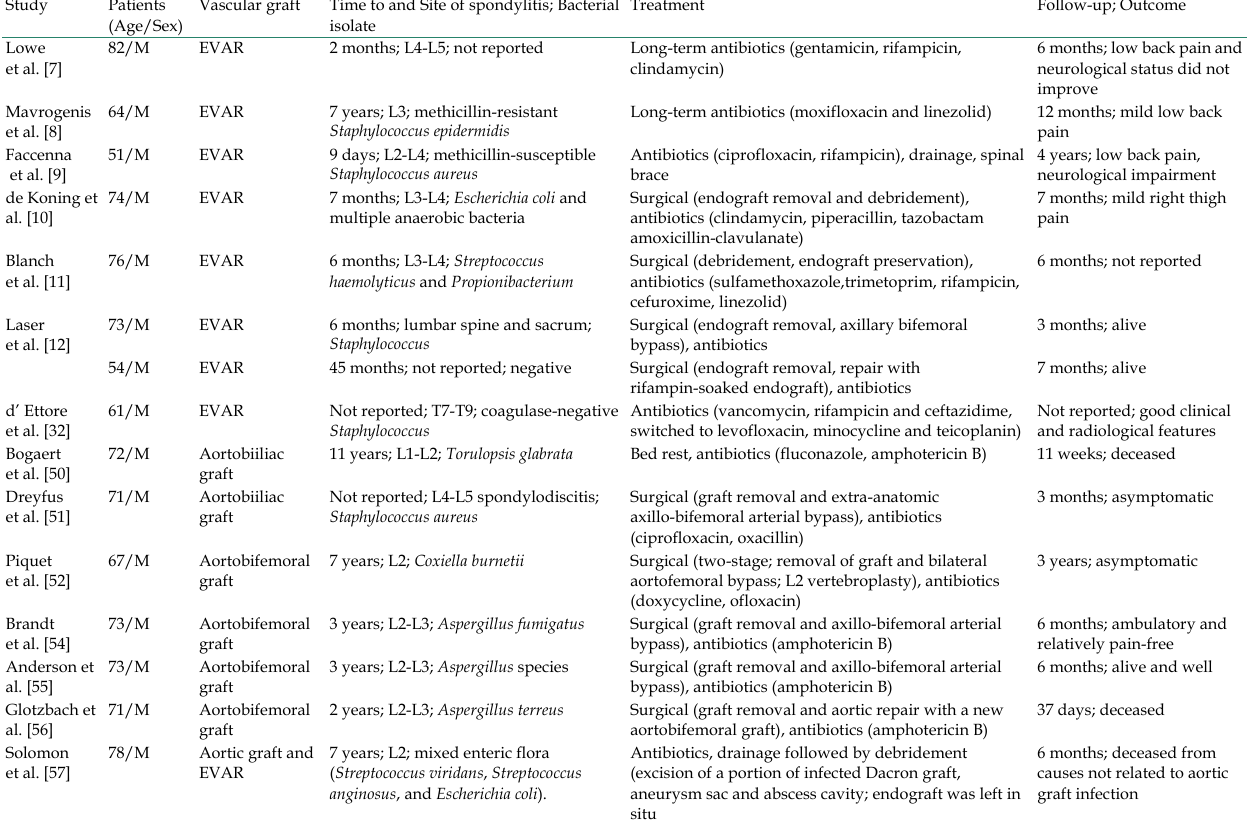
Table 1. Summary of published studies on spondylitis transmitted from an infected aortic graft.